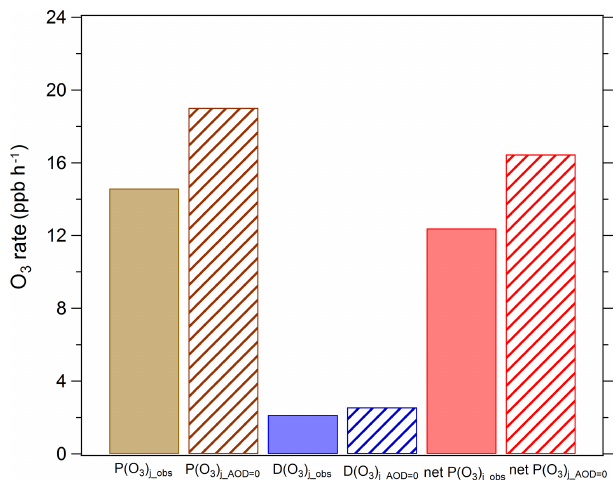
Figure 8. Mean daytime ozone production and loss terms in Au- gust 2012. P( O 3 ) j _obs , D( O 3 ) j _obs , and net P( O 3 ) j _obs repre- sent ozone production rate, ozone loss rate, and net ozone produc- tion rate under observed photolysis frequencies; P( O 3 ) j _AOD = 0 , D( O 3 ) j _AOD = 0 , and net P( O 3 ) j _AOD = 0 represent ozone produc- tion rate, ozone loss rate, and net ozone production rate under cal- culated photolysis frequencies when AOD is equal to 0.